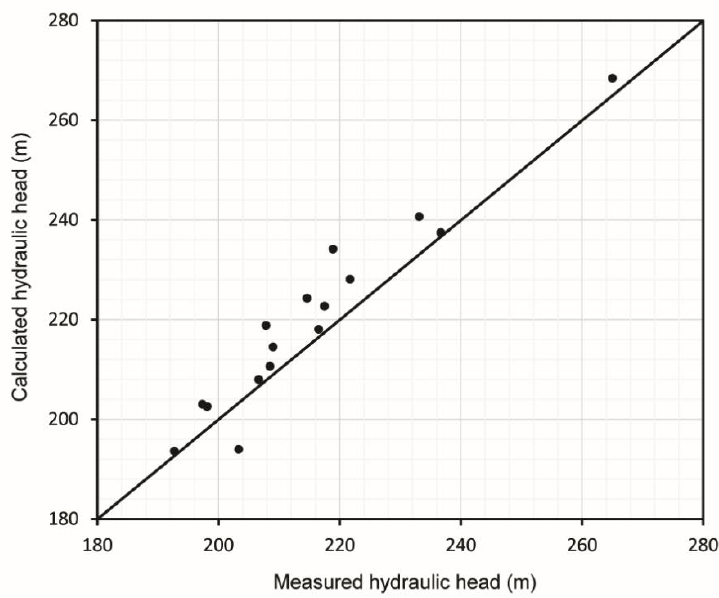
Figure 3. Comparison of calculated hydraulic heads with measured values. Reprinted by permission from Springer Customer Service Centre GmbH: Springer HYDROGEOLOGY JOURNAL (Performance evaluation of a ground-source heat pump system utilizing a flowing well and estimation of suitable areas for its installation in Aizu Basin, Japan, Shrestha et al., 2017).